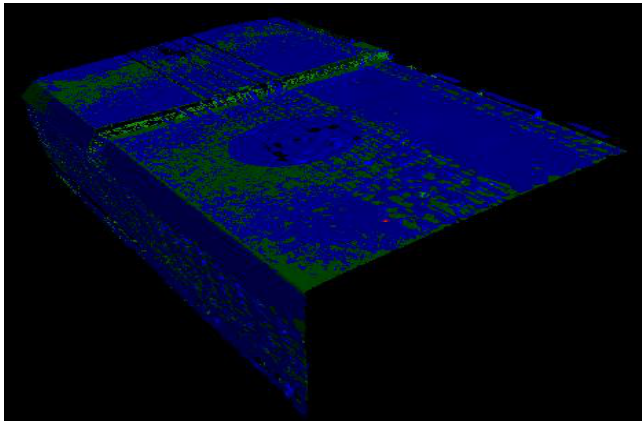
Figure 9. Comparison of two models constructed by two datasets acquired in different time